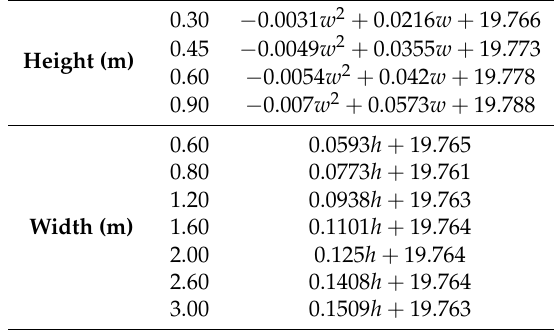
Table A2. Operative temperature t op ( ◦ C) in function of panel width and height, 21-type.